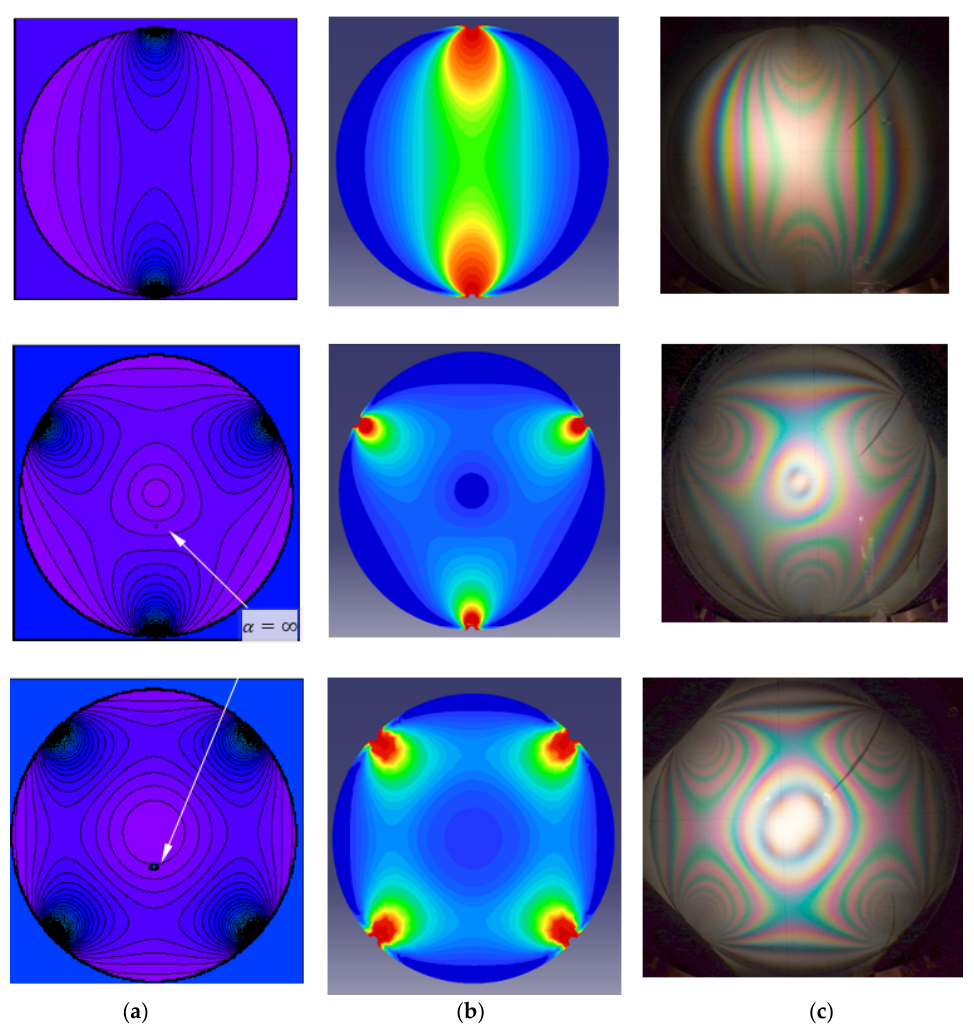
Figure 11. The isochromatic fields for a compact disk for Cases a, c and f of loading according to Table 1: ( a ) theoretical, ( b ) numerical and ( c ) experimental.